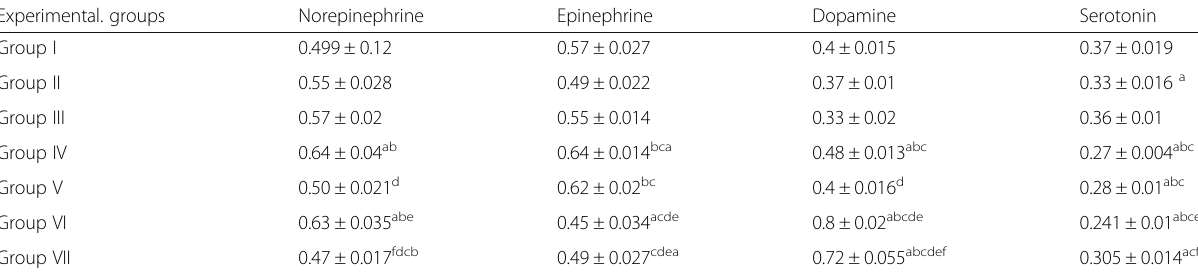
Table 4 The levels of monoamines ( μ g/g) in the cerebral cortex of male offspring in groups I to VII, 70 days postnatal. Data were presented as a mean of eight rats ± SEM Experimental. groups